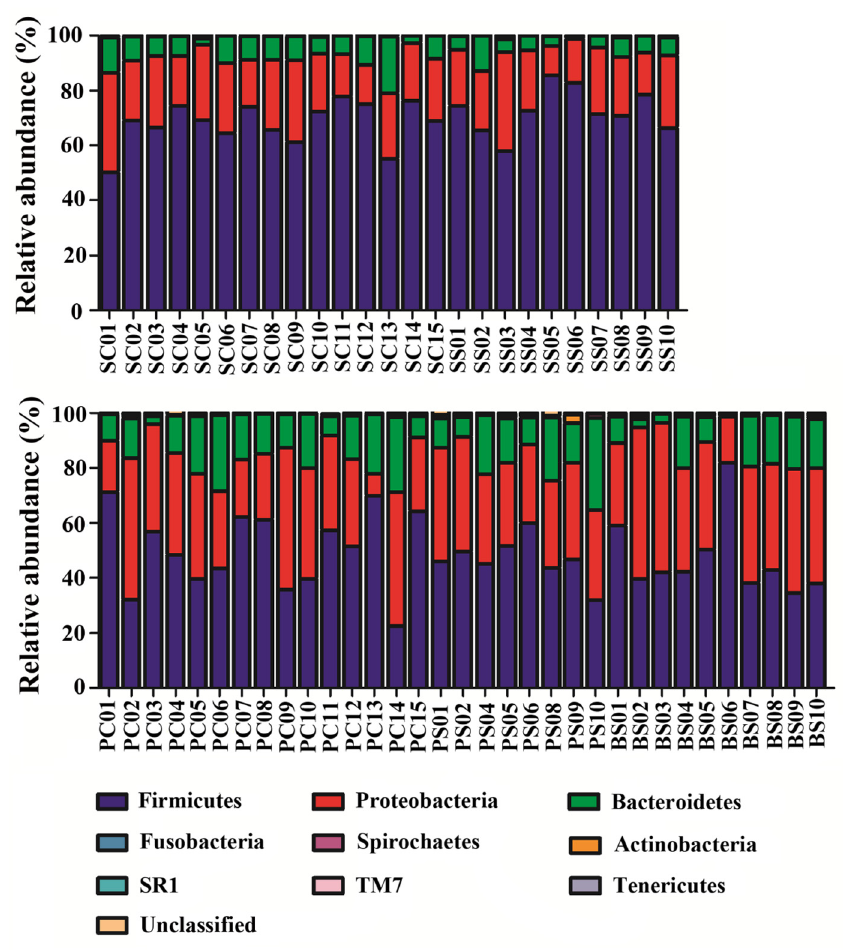
Fig 2. Relative abundance of bacterial composition at phylum level in saliva and plaque as well as black stain (BS) samples.